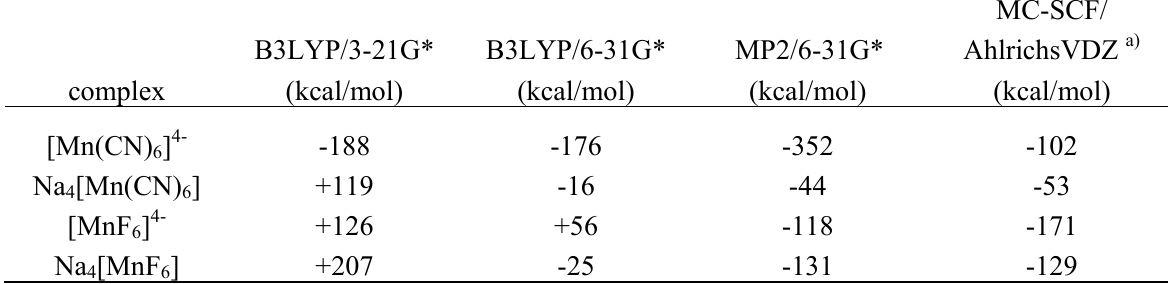
a see footnote to Table 1.